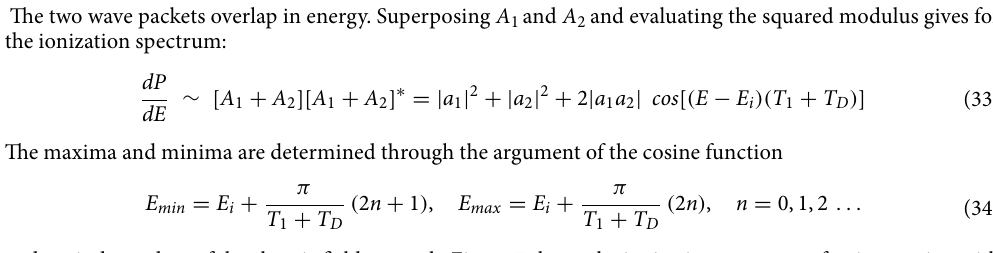
N 2, ω 2, T D 2 π/ω . The curves correspond to 2 = = = = 1 ; red curve: E 0 2 . The vertical lines illustrate the positions of the = =